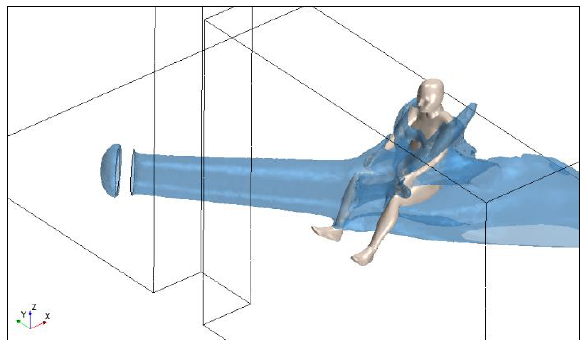
Figure 18. Velocity iso-surface of 0.4 m/s to visualize the fan jet spreading over the manikin. Thermal Comfort